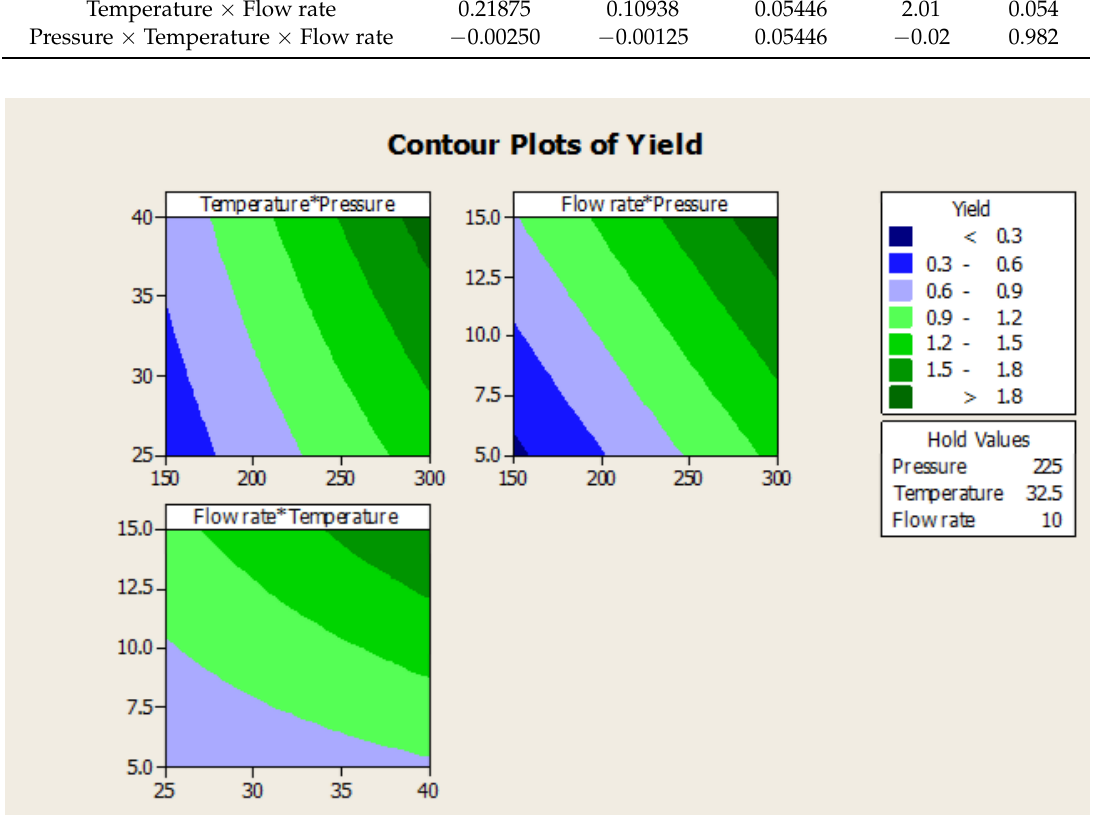
Figure 9. Contour plots of yield vs. pressure, temperature, and flow rate.